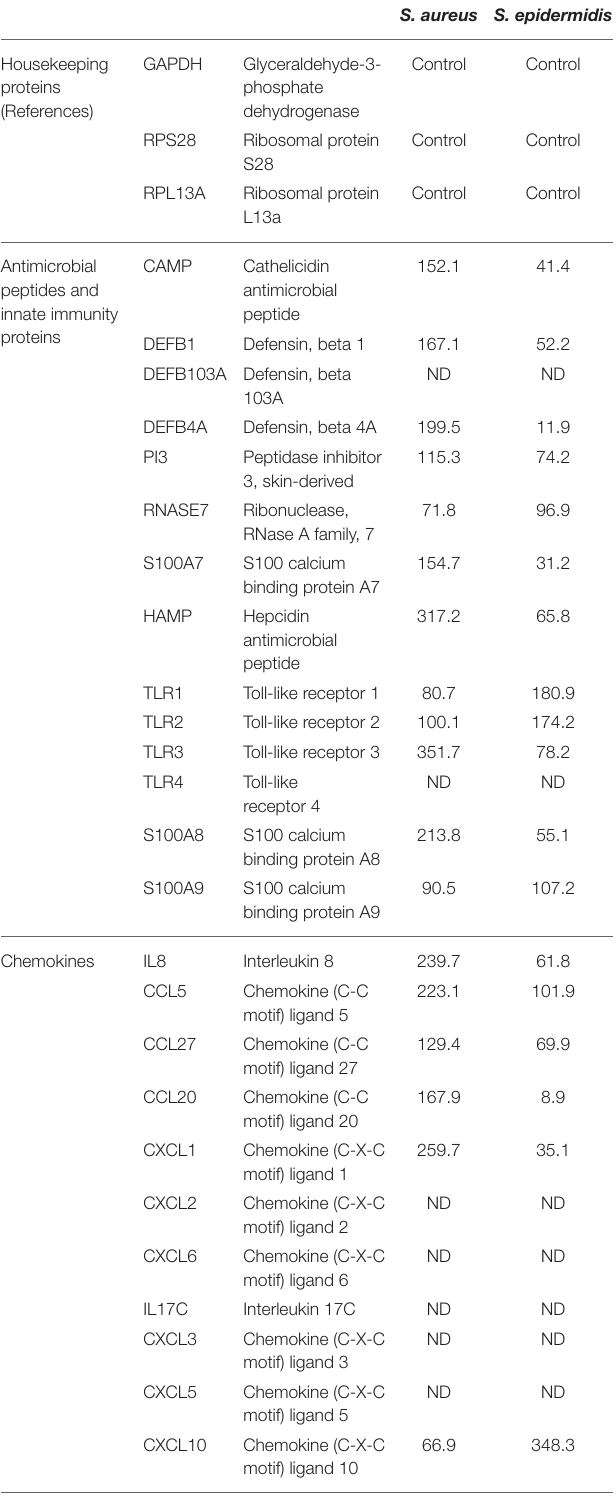
TABLE 1 | List of the 64 genes encoding proteins investigated by qRT-PCR microarrays and mRNA expression calculated as percentage of control genes